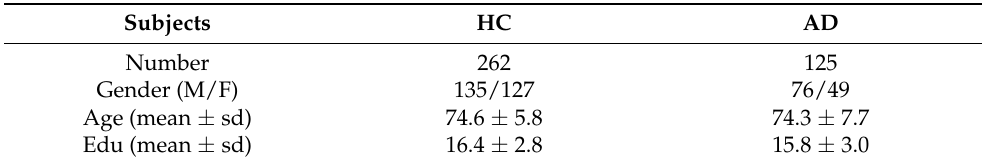
Table 1. Participant characteristics. HC = healthy control; AD = Alzheimer’s disease; M/F = male/ female; Edu = education; sd = standard deviation.